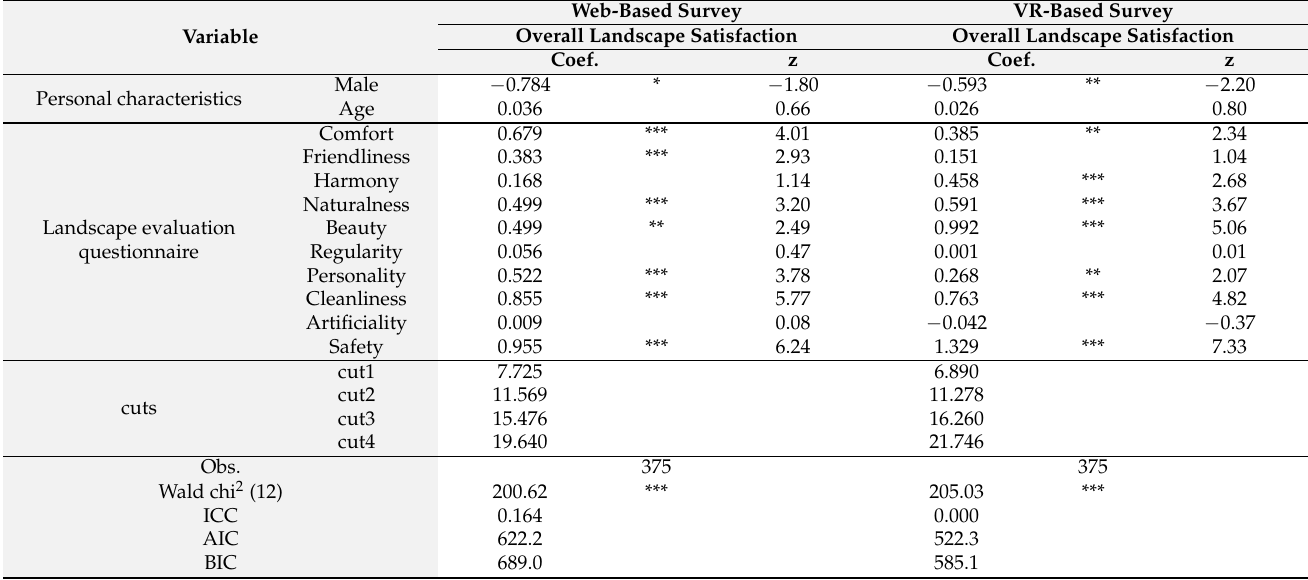
Table 4. Results of multi-level ordered logistic regression for streetscape satisfaction. Web-Based Survey VR-Based Survey Overall Landscape Satisfaction Overall Landscape SatisfactionVariable